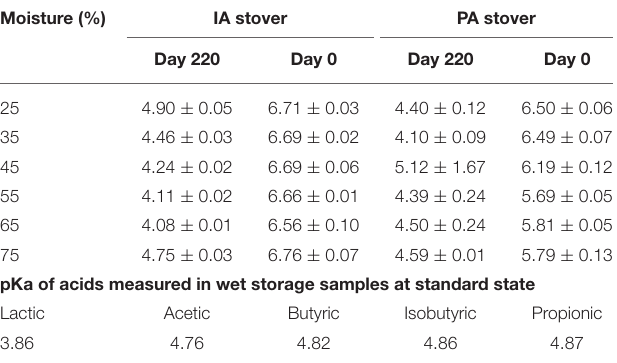
TABLE 2 | pH of IA and PA stover at different storage